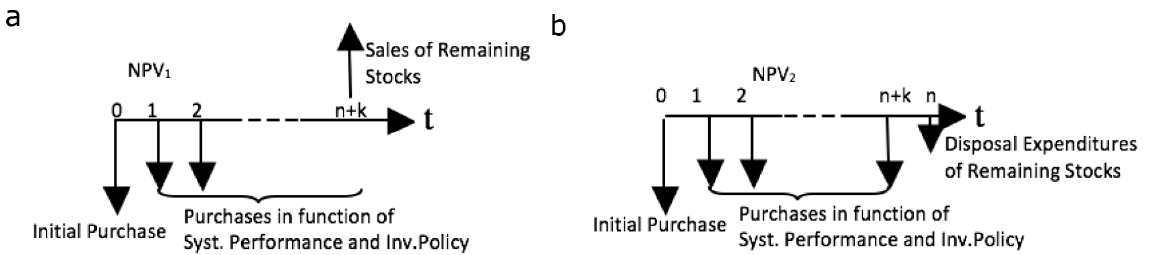
Figure 2. (a) Cash flow with final disposal and selling of the remaining stock. (b) Cash flow with final